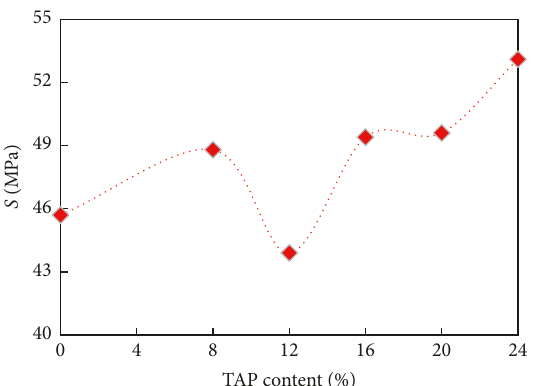
Figure 12: Creep stiffness of modified asphalt with different